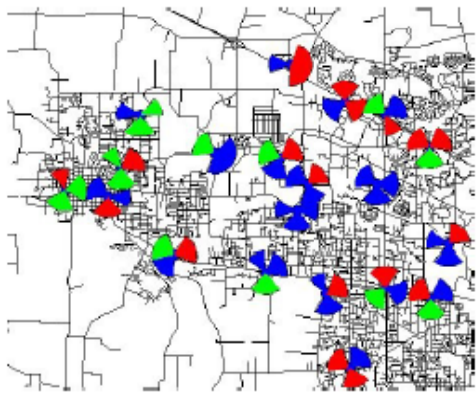
Fig 4: Deployment of femtocell network in residential area